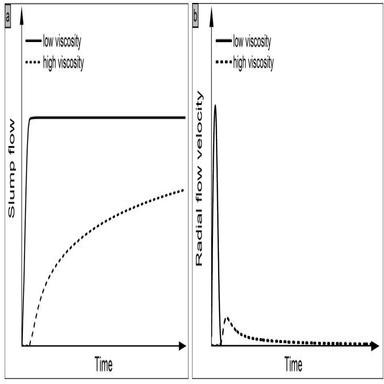
An example of slump flow (a) and radial flow velocity (b) over time for low- and high-viscosity mixes.